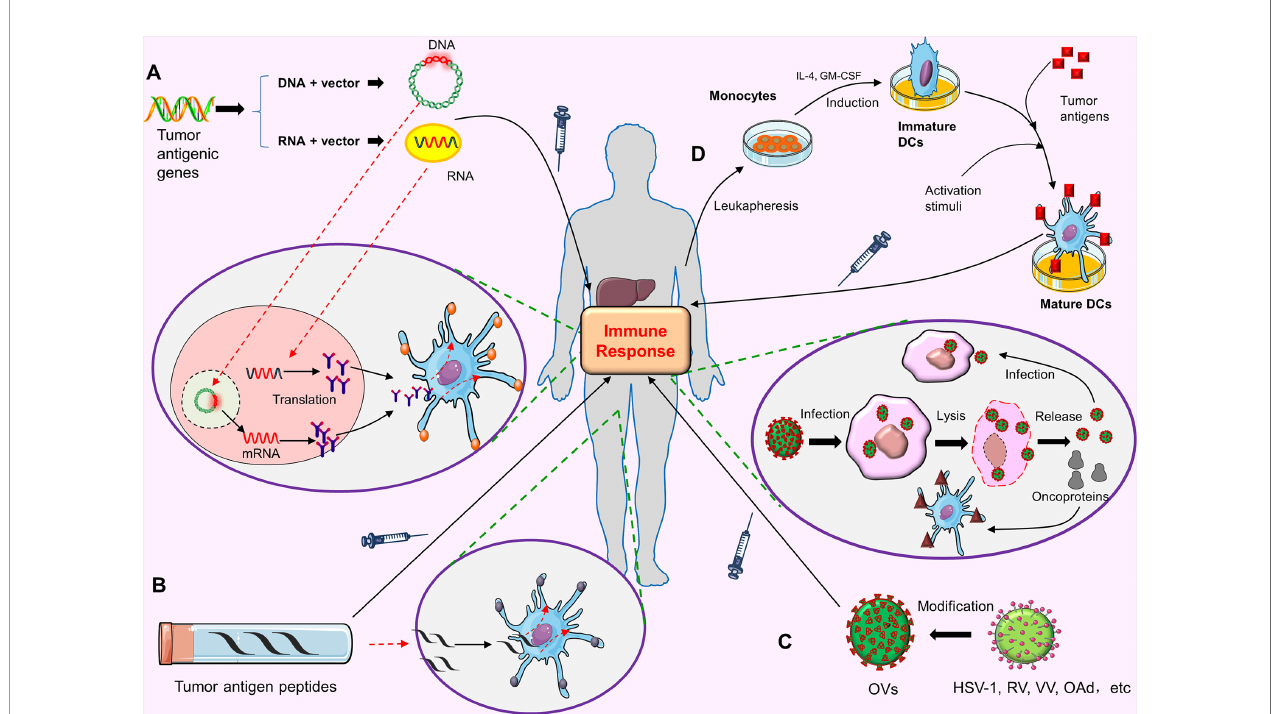
FIGURE 2 | The preparation process and anti-tumor mechanism of tumor vaccines. (A) Nucleic acid vaccines. The gene (DNA or RNA) encoding a tumor antigen is recombined with the vector and injected into the patient. DNA needs to enter the nucleus of the host cells, while RNA only needs to enter the cytoplasm of the host cells to be translated into the corresponding proteins. These proteins are secreted out of cell, captured by APCs, and fi nally activate the human immune response to this tumor antigen. (B) Peptide vaccines. High-dose tumor antigen peptides are delivered to the MHC molecules on APC surface, thus stimulating the speci fi c immune response of the body to this tumor antigen. (C) Oncolytic viruses(Ovs). OVs can be modi fi ed from HSV-1, RV, VV and OAd. OVs can infect tumor cells after entering the body, and proliferate in large amounts in tumor cells, eventually leading to tumor cell lysis and death. Dead tumor cells release OVs virus and tumor proteins. The released OVs virus can continue to infect other tumor cells. Tumor proteins can be captured by APCs and eventually activate the host immune response. (D) DC vaccines. Monocytes are extracted from the blood of patients. These monocytes are induced to become Immature DCs under the stimulation of IL-4 and GM-CSF. Then under the action of activation stimuli, the tumor antigens are loaded on the Mature DCs. Finally, these DCs loaded with tumor antigens are injected into the body to cause the body to produce the immune response to tumor